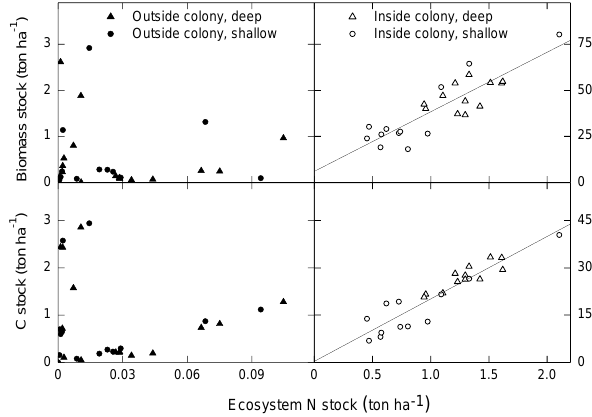
Figure 5. Mean ( ± SE) values of the biomass stock and C stock of litter, shoots, roots (to 30cm depth) and SOC (to 30cm depth) Fig. 5. Mean (±SE) values of the biomass stock and carbon stock of litter, shoots, roots (to 30 cm 717 in four ecosystem types on Surtsey. The inserted graphs give the depth) and soil organic carbon (SOC) (to 30 cm depth) in four ecosystem types on Surtsey. The 718 values outside the seabird colony in more detail. “Shoots” include aboveground living vascular plant parts. Statistical results are shown inserted graphs give the values outside the seabird colony in more detail.. ‘Shoots’ include 719 in Table 1. Percentages above the graph indicate the % of total C that aboveground living vascular plant parts. Statistical results are shown in Table 1. Percentages 720 is located belowground. Letters show statistical differences. above the graph indicate the % of total C that is located belowground. Letters show statistical 721 differences. 722